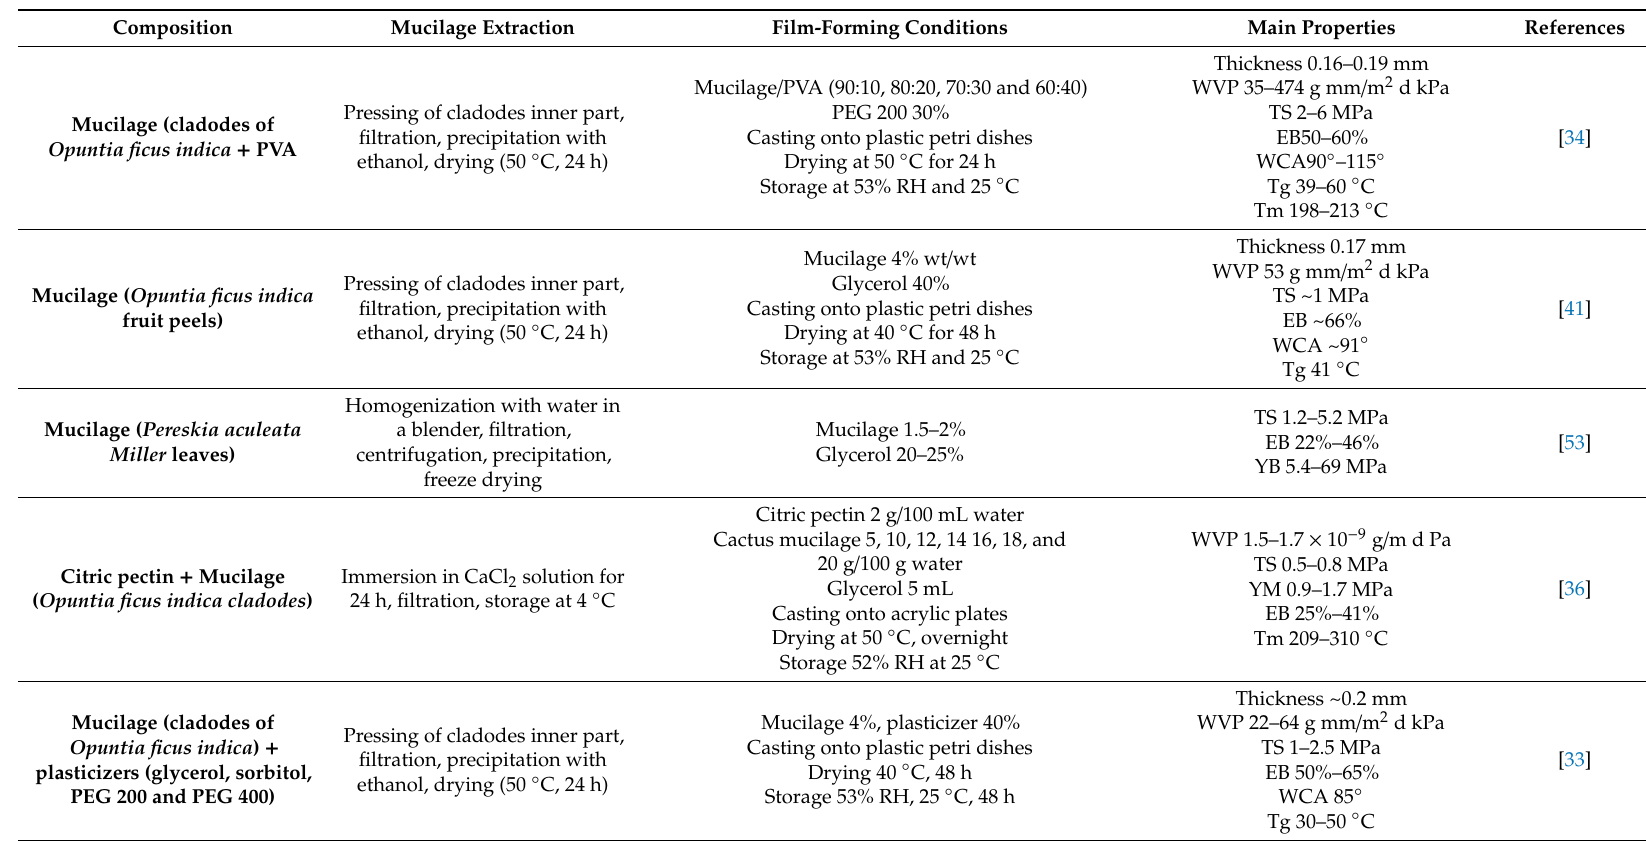
Table 2. Based on cactus